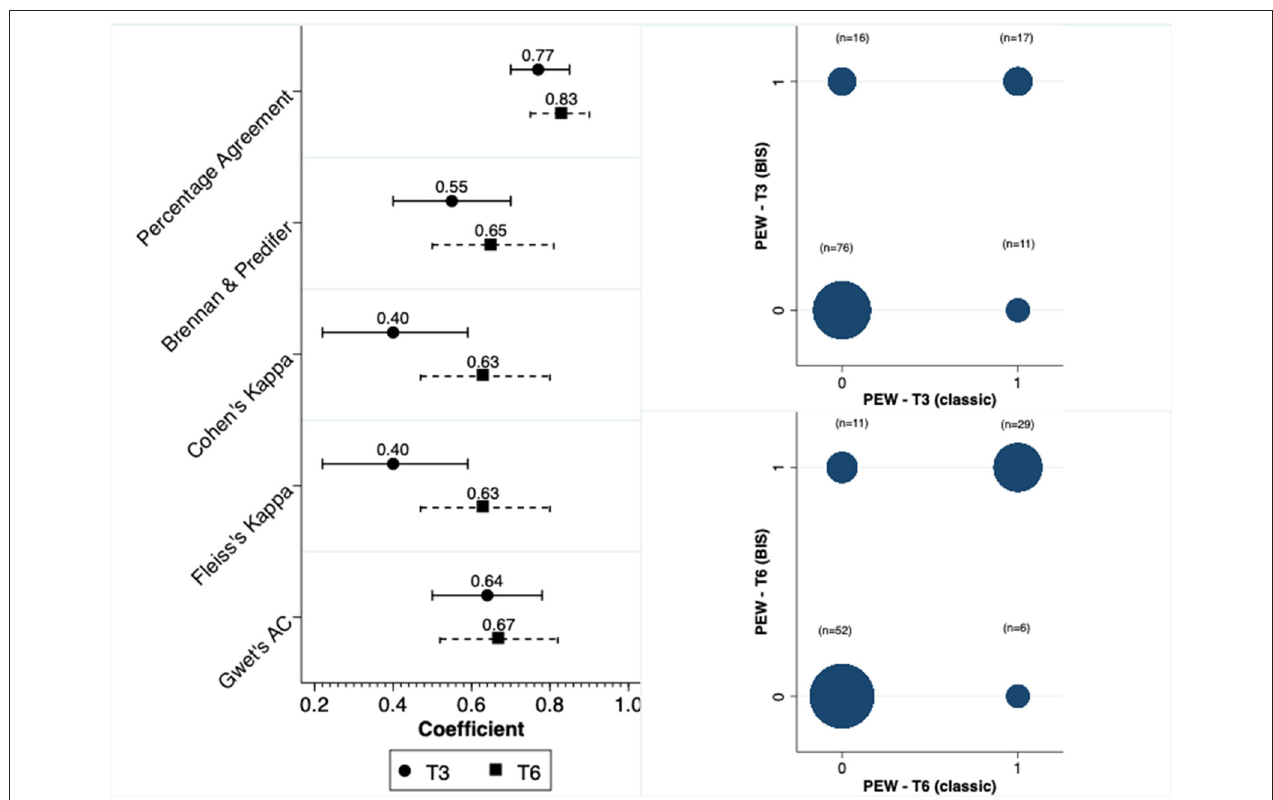
FIGURE 2 | Concordance and distribution of PEW